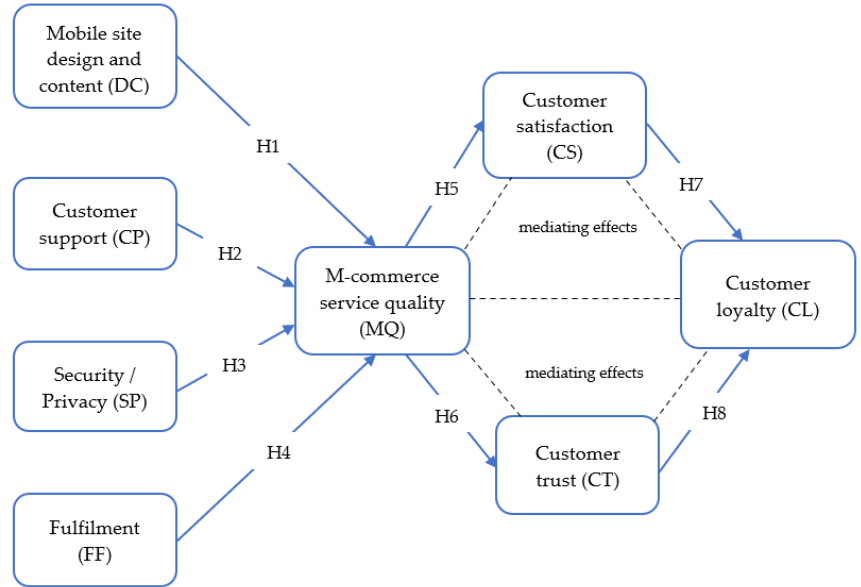
Figure 1. Description of the conceptual structural model.